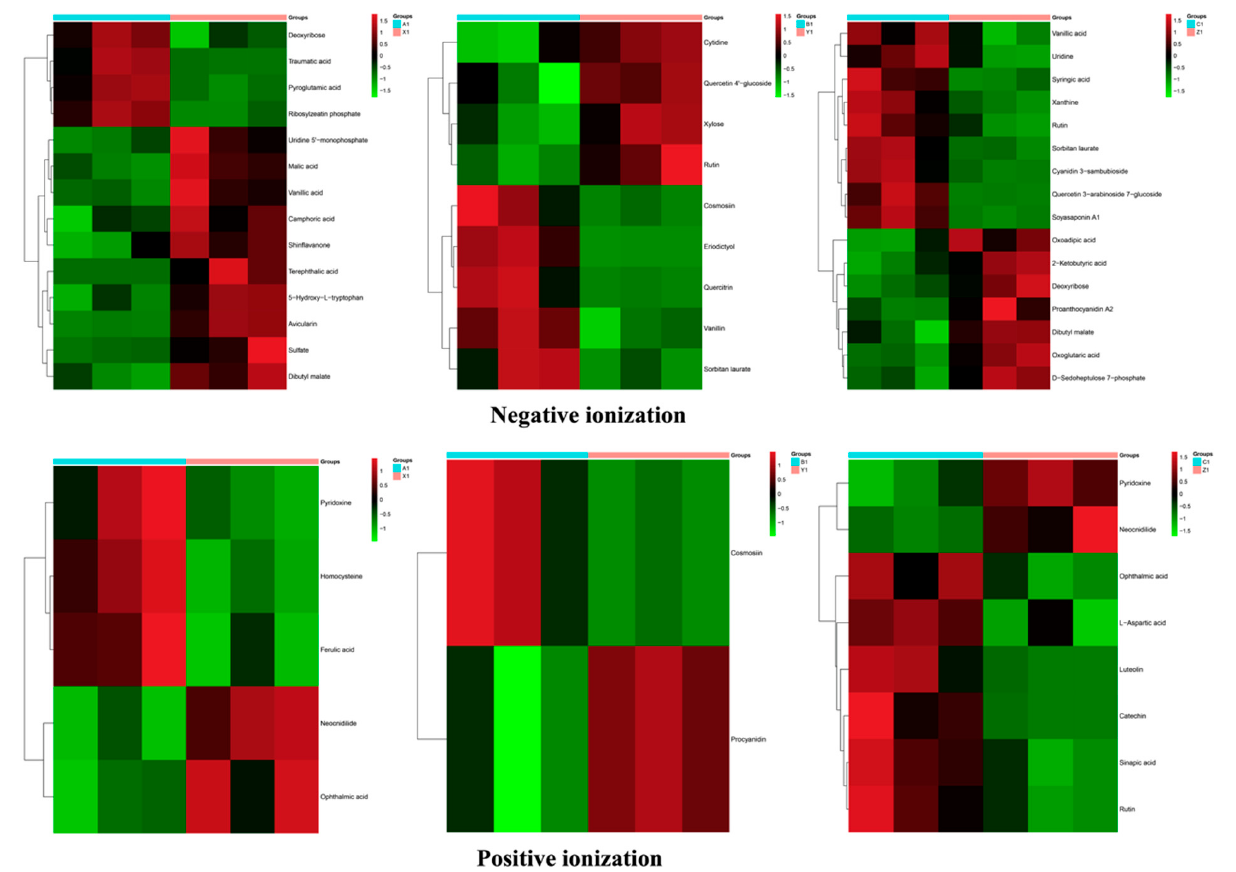
Figure 4. Hierarchical cluster analysis of metabolome data from the tolerant and sensitive genotypes in both ionization modes. SB-DT2 and stampede comparisons (C1 vs. Z1) show a higher accumulation of metabolites.